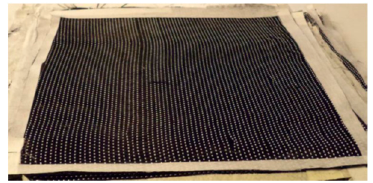
Figure 17. Fabric pre-cut to size with tape paper support.